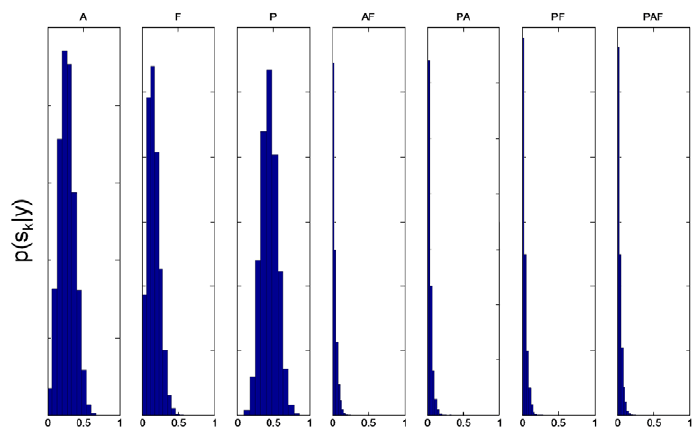
Figure 2. RFX posterior densities for input families. The histograms show p ( s k D y ) versus s k for the k ~ 1 :: 7 input families. Input family ‘P’ has the highest posterior expected probability v s k D Y w ~ 0 : 44 . See Table 1 for other posterior